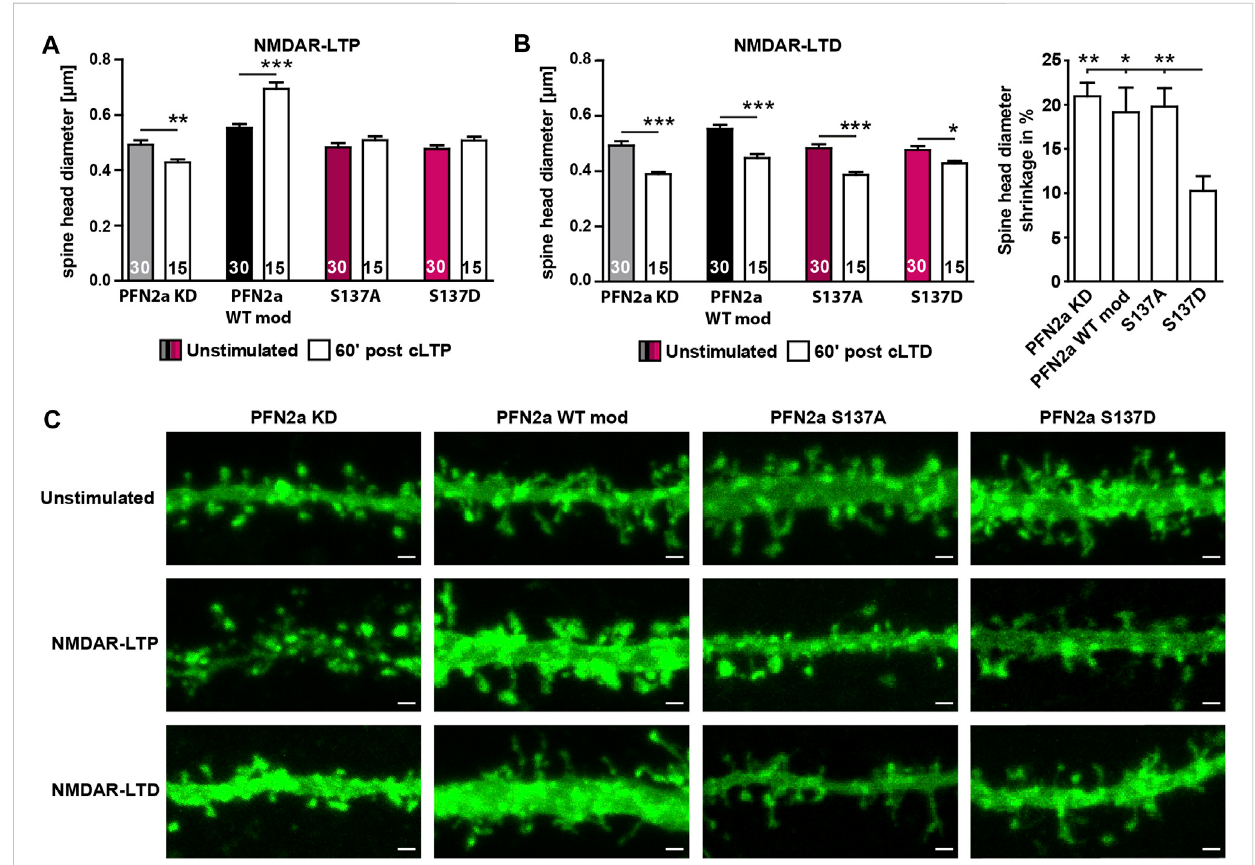
FIGURE 4 Regulation of PFN2a phosphorylation at S137 is essential for structural plasticity following NMDAR-dependent cLTP as well as cLTD induction. (A) Averagedendriticspine headdiameter 60 ′ postNMDAR-dependentcLTPinductionofspines fromhippocampalneuronswhereendogenousPFN2a had beenreplacedeitherbymApple(KD),WTPFN2a(WTmod),PFN2aS137AorPFN2aS137D. n =30(Unstimulated),15(cLTP)dendriteseach(1dendritewas analyzed per neuron). N = 3 experiments. (B) Average dendritic spine head diameter 60 ′ post NMDAR-dependent cLTD induction of spines from hippocampal neurons where endogenous PFN2a had been replaced either by mApple (KD), WT PFN2a (WT mod), PFN2a S137A or PFN2a S137D. n = 30 (Unstimulated),15(cLTD)dendriteseach(1dendritewasanalyzedperneuron).N=3experiments.Notethat,althoughspineshrinkagecouldbeobserved under all experimental conditions, when comparing the percentage of spine head shrinkage following cLTD induction, spine shrinkage was signi fi cantly reduced by ~50% in neurons expressing the PFN2a S137D phospho-mimetic. (C) Example images depicting individual dendritic stretches from hippocampal neurons where endogenous PFN2a had been replaced either by mApple (KD), WT PFN2a (WT mod), PFN2a S137A or PFN2a S137D either unstimulated or 60 ′ post NMDAR-LTP or NMDAR-LTD induction. Scale bars - 1